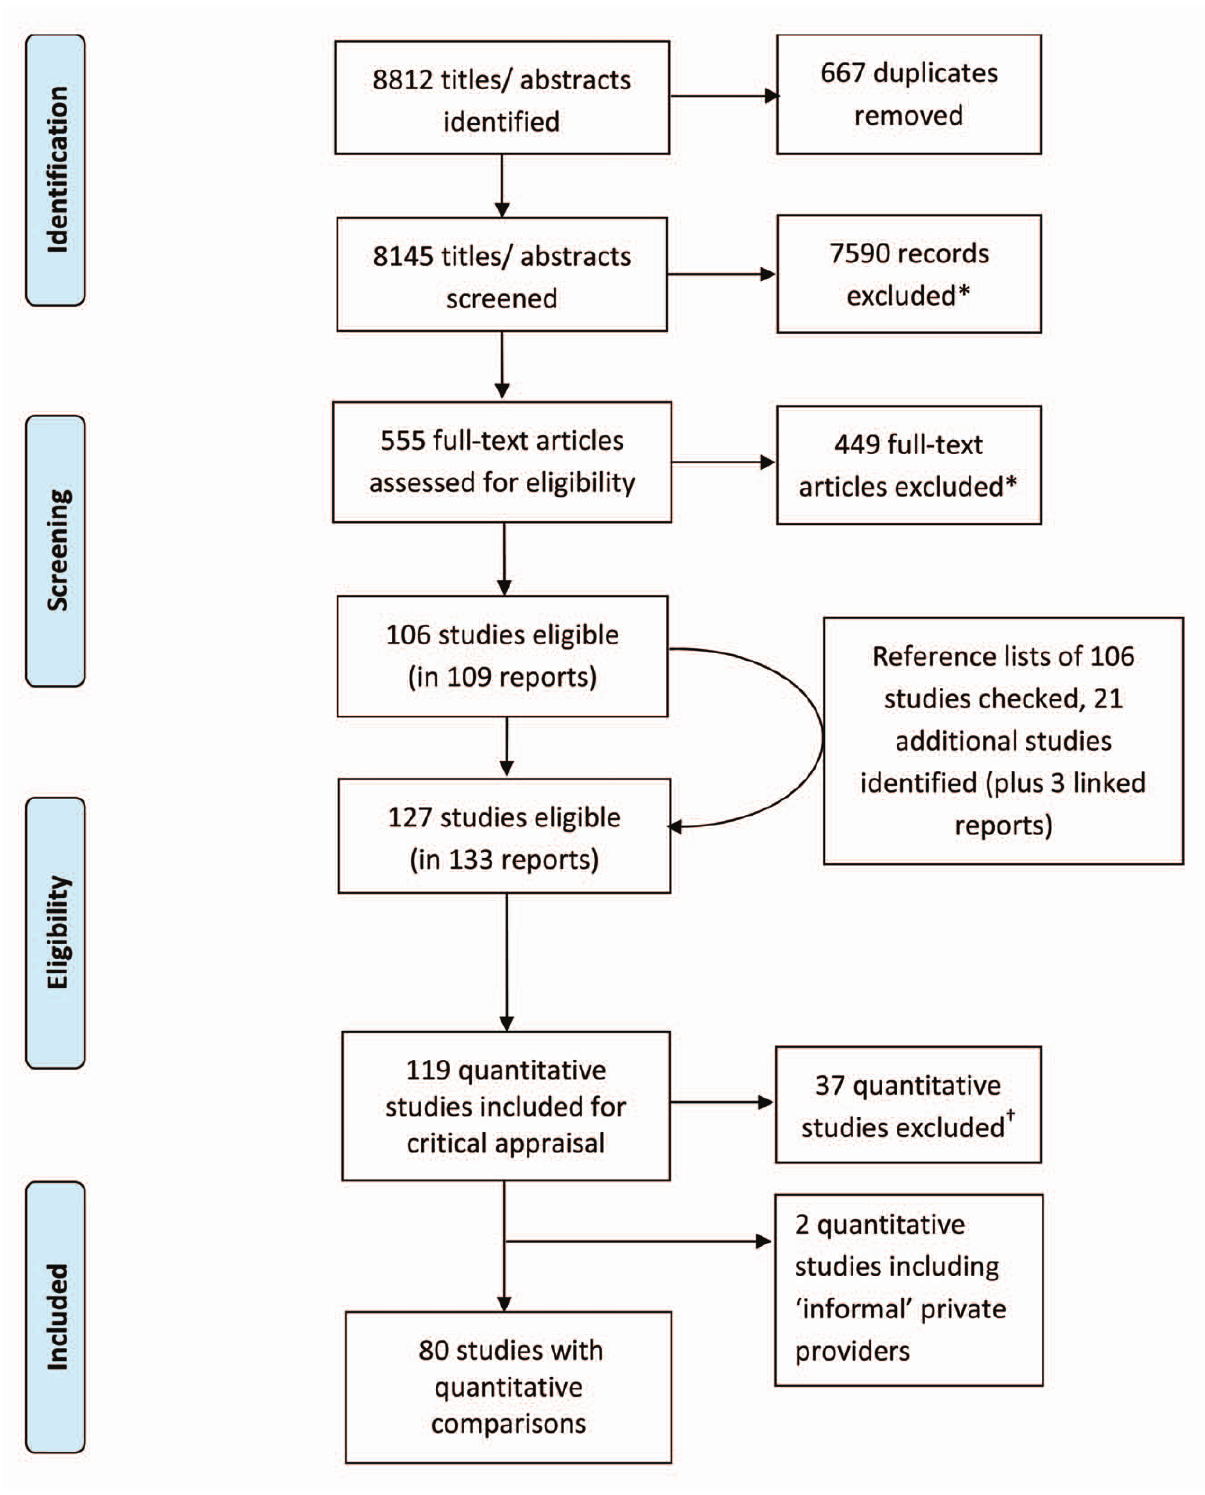
Figure 1. Selection of studies. * See Table S4 for reasons of exclusion; { see Table S5 for reasons of exclusion. doi:10.1371/journal.pmed.1000433.g001 For drug availability, private-sector care was substantially better than public-sector care, from 14 comparisons. Nine studies used a standard method and referred to the WHO essential drug list